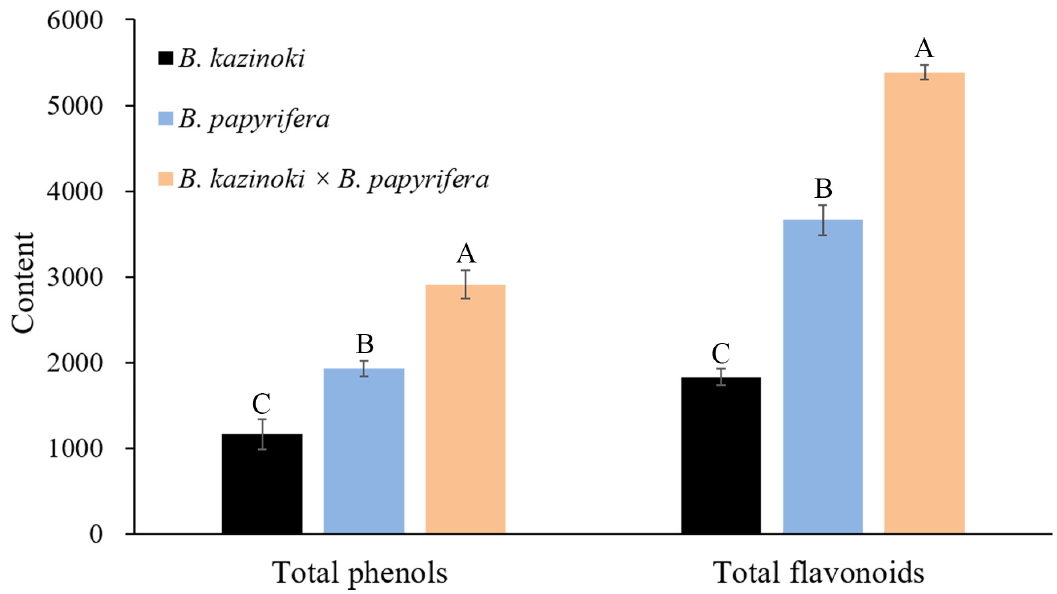
Figure 5. Total polyphenol content (TPC) and total flavonoid content (TFC) of leaf extracts from B. kazinoki , B. papyrifera and B. kazinoki × B. papyrifera . Values are mean ± SD ( n = 3). Letters above each pillar indicate significantly different values among samples according to ANOVA at p < 0.01.